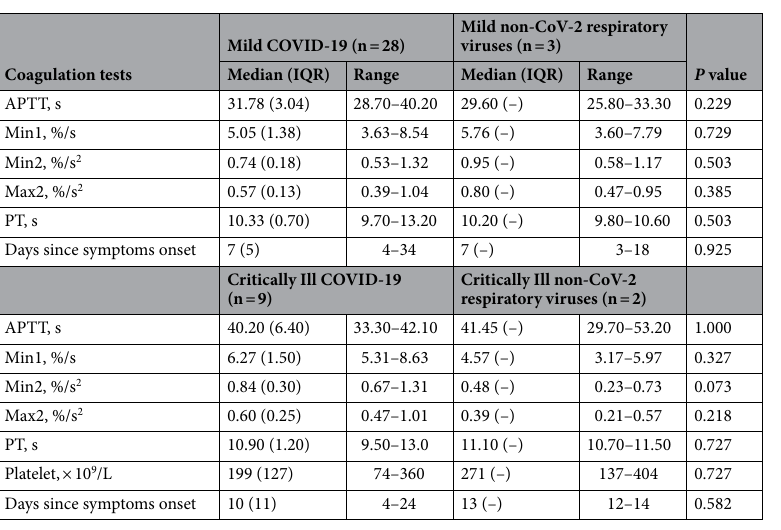
Table 4. Inter-individual comparison of coagulation data (PT, aPTT and aPTT-based clot waveform analysis profiles) between mild COVID-19 and non-CoV-2 respiratory viral infections^, as well as between critically ill COVID-19 and non-CoV-2 respiratory viral infections # . * No D-dimer and fibrinogen data presented as these results were not available in the mild non-CoV-2 respiratory viruses group. ^ Mild COVID-19 and non-CoV-2 respiratory viral infections defined as patients who did not require supplementary oxygen support throughout course of infection. # Critically ill COVID-19 and non-CoV-2 respiratory viral infections defined as patients who required intensive care unit support. All data were taken prior to the administration of prophylactic